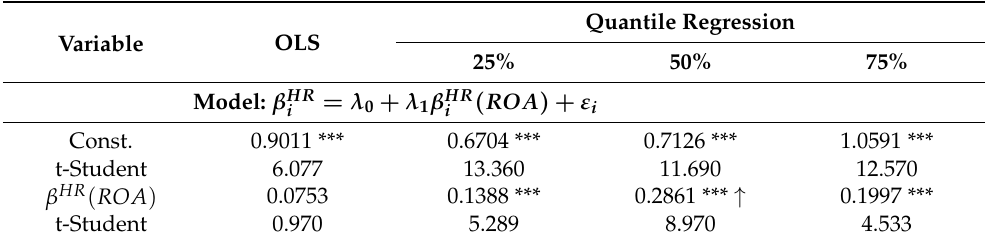
Table 11. Estimates of the relationship between systematic market downside risk and systematic accounting downside